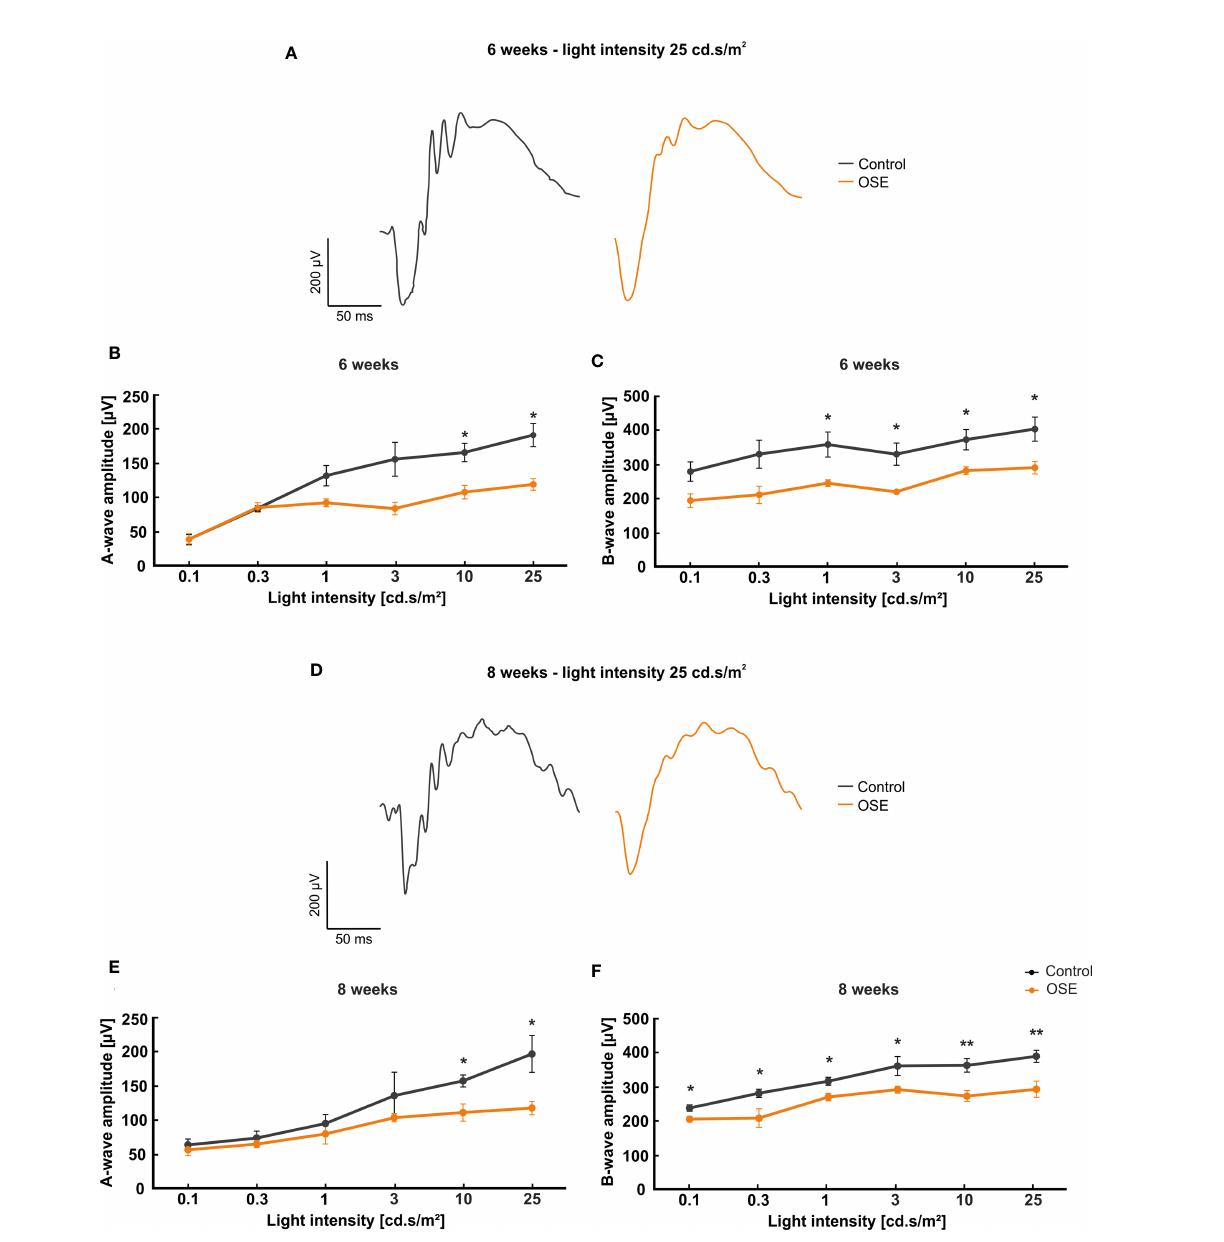
FIGURE 2 | Functional impairment of the retina. (A) Exemplary ERG amplitudes at 25 cd.s/m 2 fl ash luminance at six weeks. (B) At six weeks, the a-wave amplitude, representing the photoreceptors, was reduced in the OSE group. (C) The b-wave amplitude, which illustrates the conductivity of the inner retinal layers, was signi fi cantly reduced in OSE animals in comparison to the control group. (D) Exemplary ERG amplitudes at a fl ash luminance of 25 cd.s/m 2 in eight-week-old mice. (E) The ERG measurements after eight weeks again displayed a reduced a-wave amplitude in OSE. (F) Also, a loss of the electrical output was noted after eight weeks regarding the b-wave amplitude of OSE mice. Data are shown as mean ± SEM. *p < 0.05, **p <